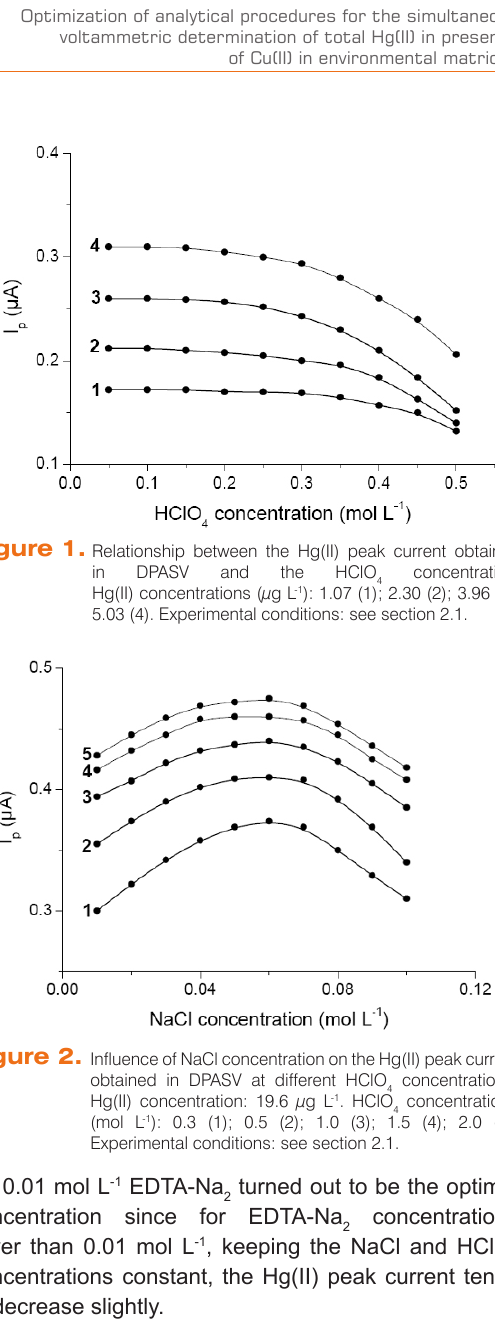
concentrations. 4 concentrations 4